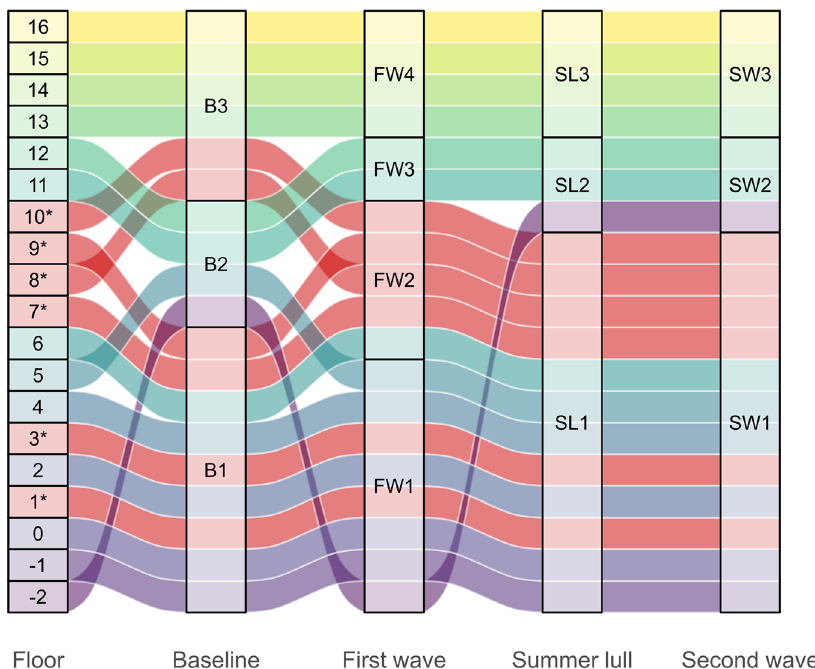
Fig. 4 The spatial connectivity of fl oors in the Tower building at University College London Hospital during the fi rst year of the COVID-19 pandemic. The alluvial diagram depicts the connectivity of fl oors, as determined from the Louvain clustering algorithm and using dyadic weights derived from the number of healthcare workers with door events and/or patient contacts on the focal fl oors during the same day. The numbering in the left most column identi fi es the fl oors, and the codes in the remaining four columns represent the cluster group the fl oors belong to in each stage of the pandemic; pre- pandemic (baseline; B), fi rst wave (FW), summer lull (SL) and second wave (SW). Floors that handled the majority (> = 15%) of COVID-19 patients during the observation period are identi fi ed by an asterisk and their fl ows between clusters are in red. The fl ows for non COVID-19 fl oors are differentiated by colours ranging from yellow to